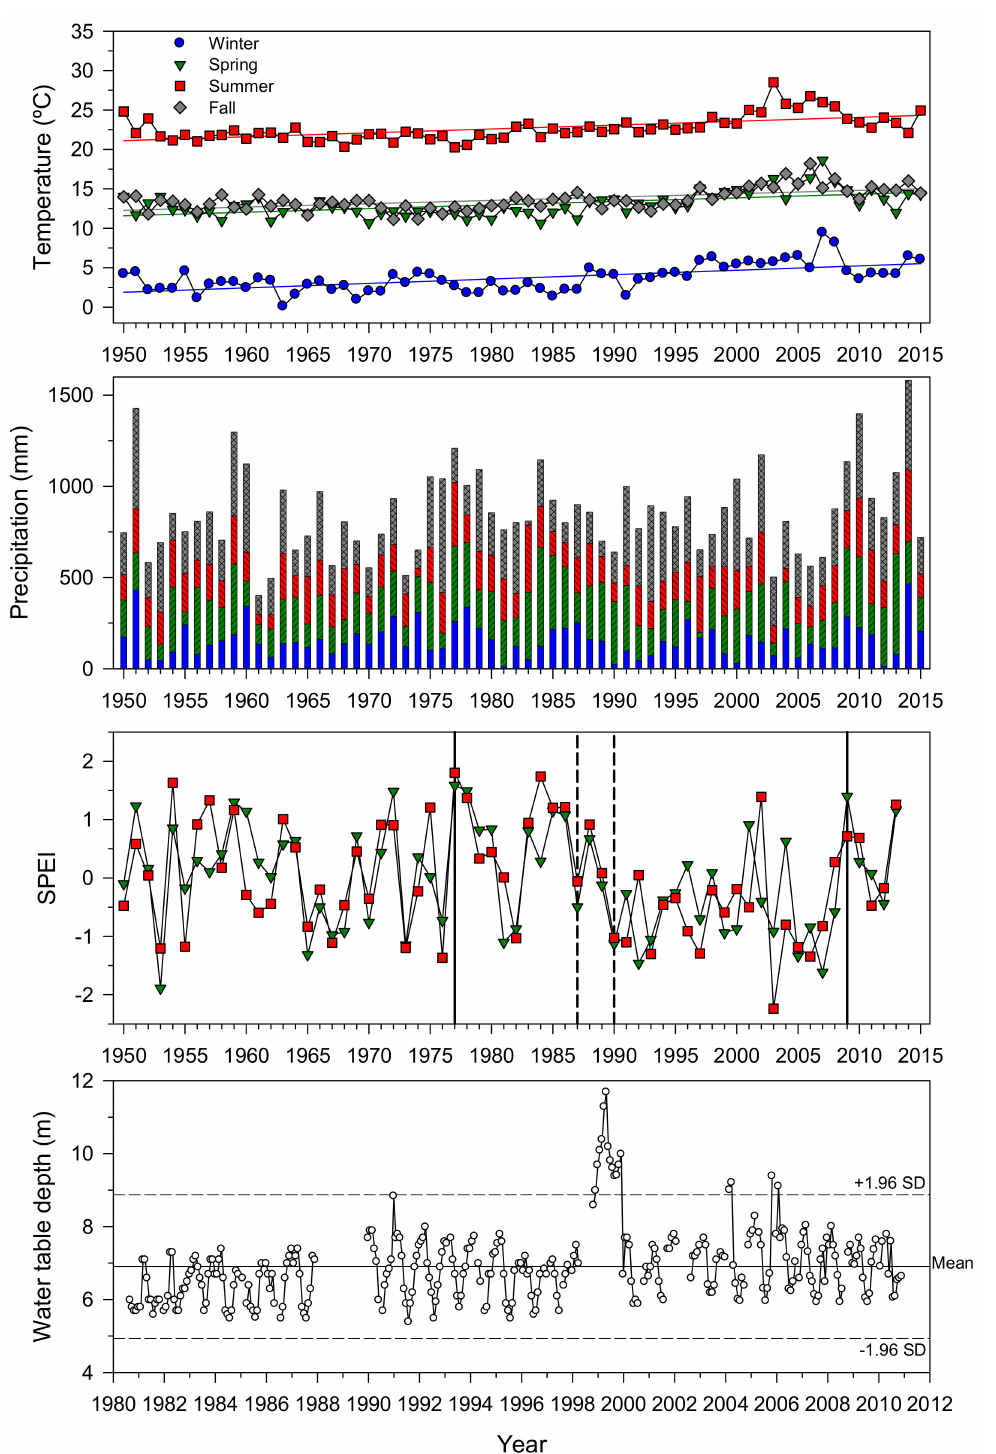
Figure 1. Climate trends in the study area (mean temperature with corresponding trend lines, seasonal precipitation) and drought severity for the 1950–2015 period (red and green symbols correspond to six-month long summer and spring SPEI values—the SPEI is the Standardized Precipitation Evapotranspiration Index), and monthly water-table depth (1980–2011 period) near the Ticino sampling site (continuous and dashed lines show the mean and the means ± 1.96 SD, respectively, corresponding to the 95% significance level). In the SPEI plot, continuous and dashed vertical lines show positive and negative shifts,